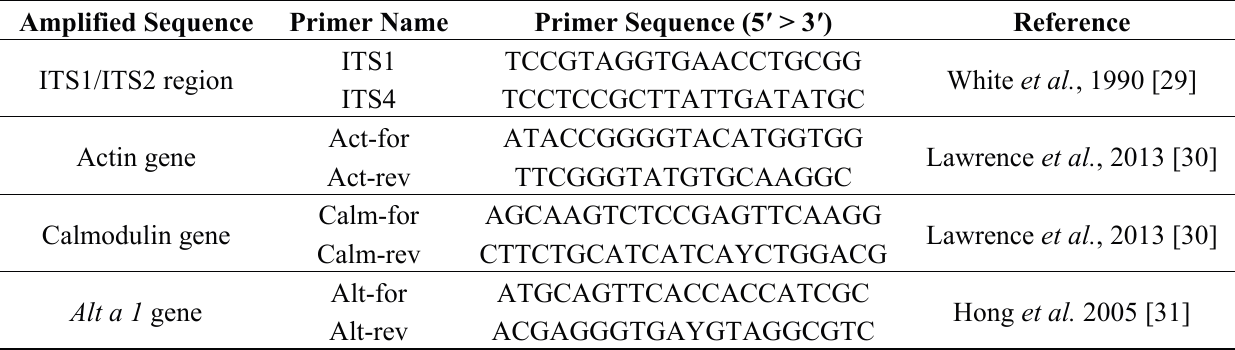
Table 2. Sequences of primers used in this